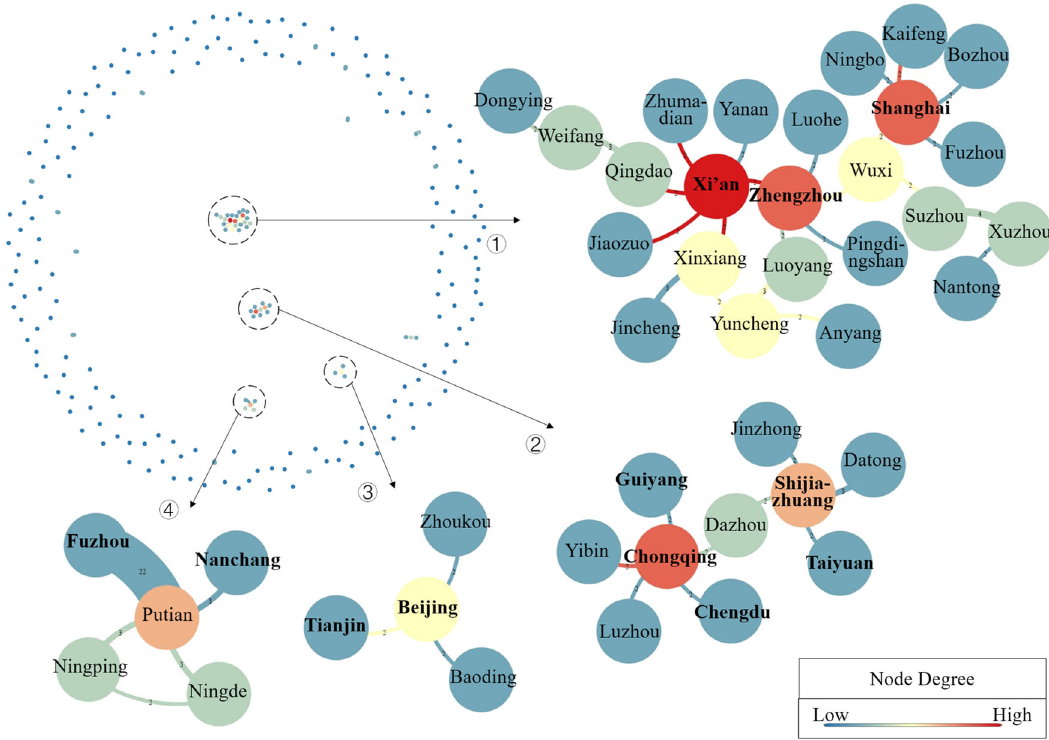
Fig. 7 City-level network of informal adoption based on the Yifan Hu algorithm layout. The colors of the nodes represent the size of the centrality. Darker blue indicates that the node has weaker contact with other nodes, and darker red indicates that it has more connections with other nodes. The colors of the edges are the same as their source. A thicker edge represents a larger quantity of cases for the path. Cities in bold are provincial capital